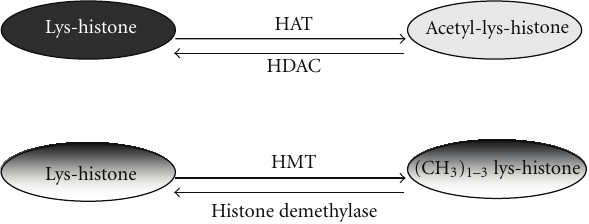
Figure 2: Main posttranslational modifications occurring on His- tone 3 and 4 are the result of dynamic activity of di ff erent